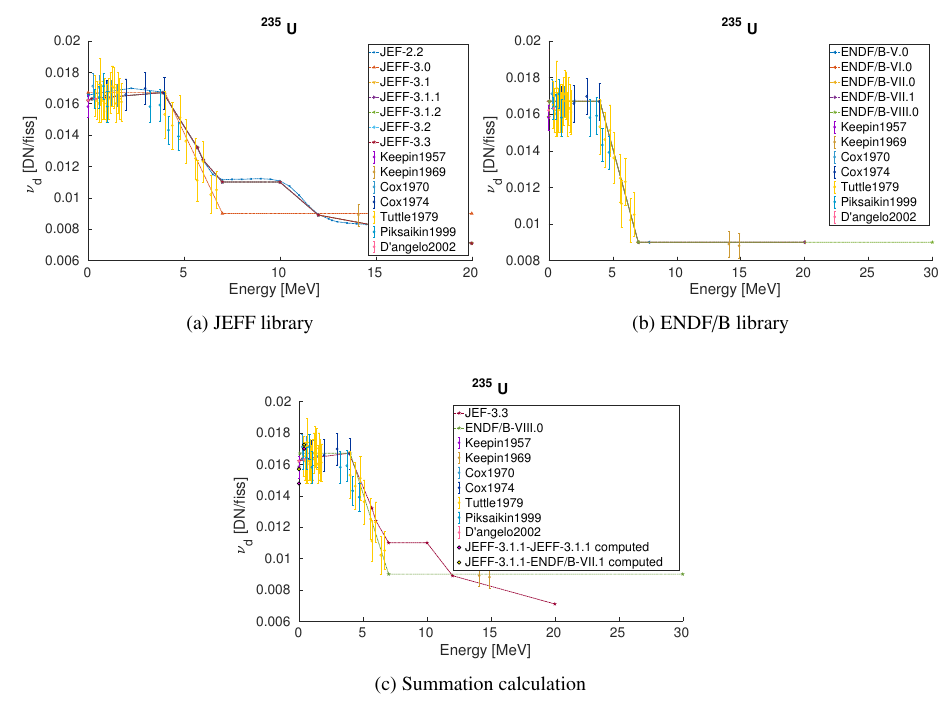
Figure 1: Library comparison of the average delayed neutron yield as a function of energy for 235 U. Fig. 1a contains all the versions of JEFF library from the 2.2 to the 3.3. Fig. 1b contains all the versions of JEFF library from the V.0 to the VIII.0. Fig. 1c contains JEFF- 3.1.1, ENDF / B-VII.1 and the points obtained with a summation calculation. All figures show experimental data for